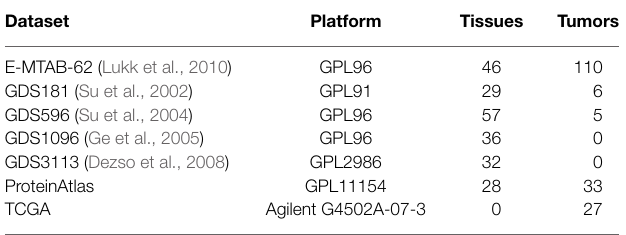
TABLE 2 | Features of expression datasets integrated in SPECTRA .